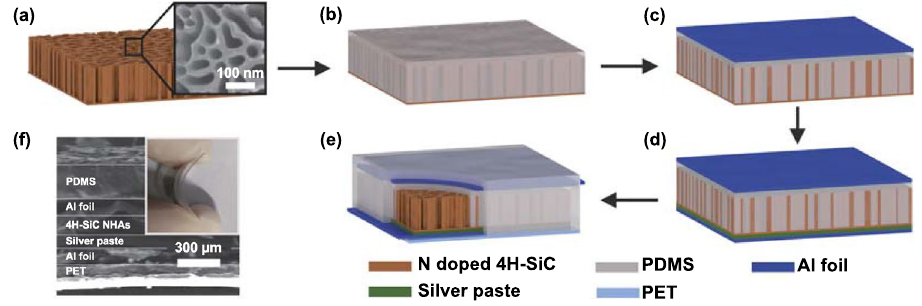
Fig. 1 a–e Schematic diagram of the fabrication process for the PENG. The inset in a is the SEM image of the top‑view of N doped 4H‑SiC NHAs. f SEM image of the cross‑sectional view of the assembled PENG. The inset in the upper right corner is the picture of bending